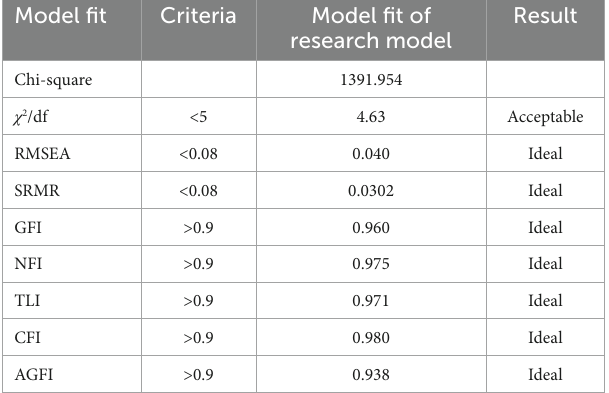
TABLE 2 Indicators of model fit.